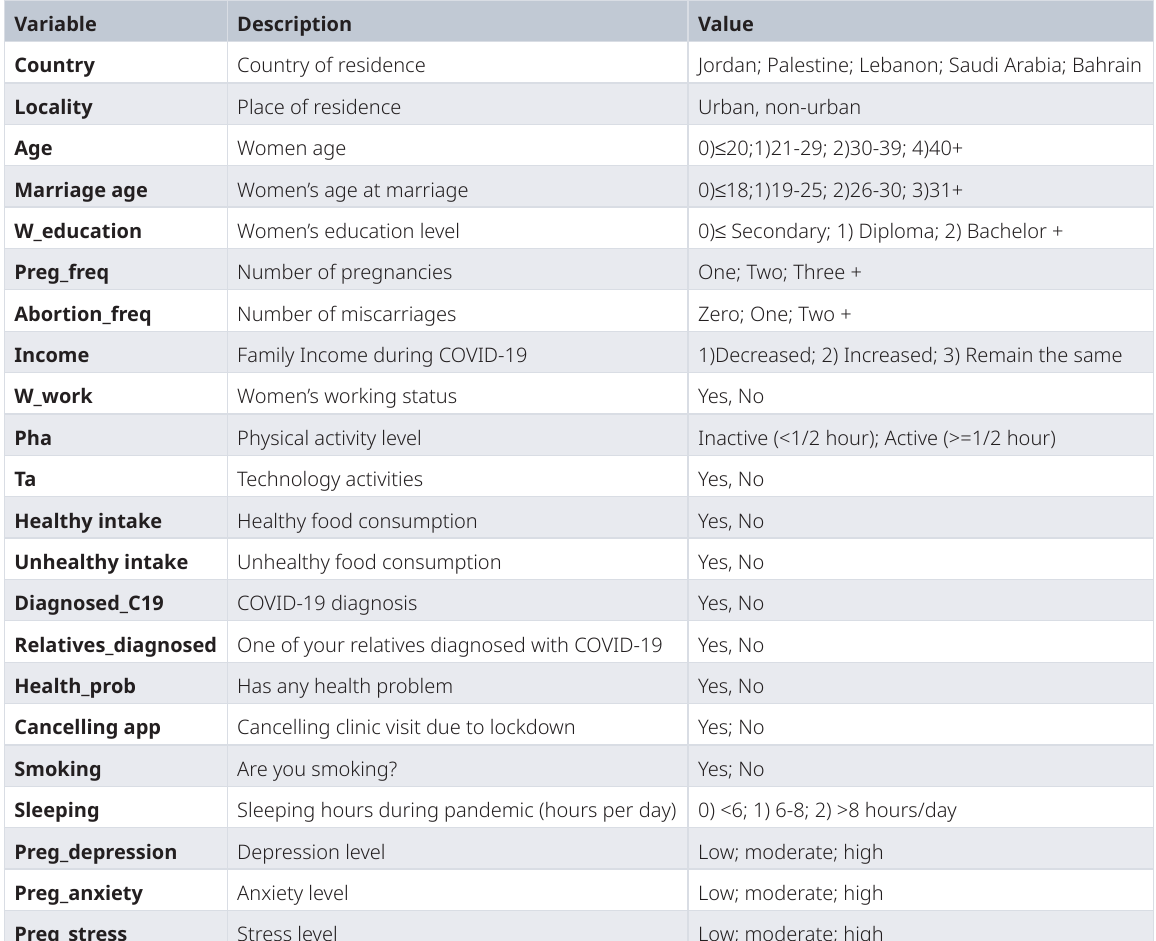
Table 1. Machine learning models variables